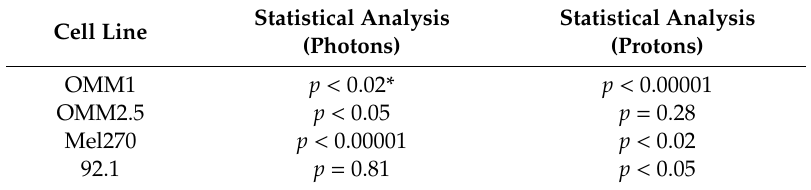
Table 2. Impact of ATM inhibition on the radiosensitivity of UM cells in response to photons and